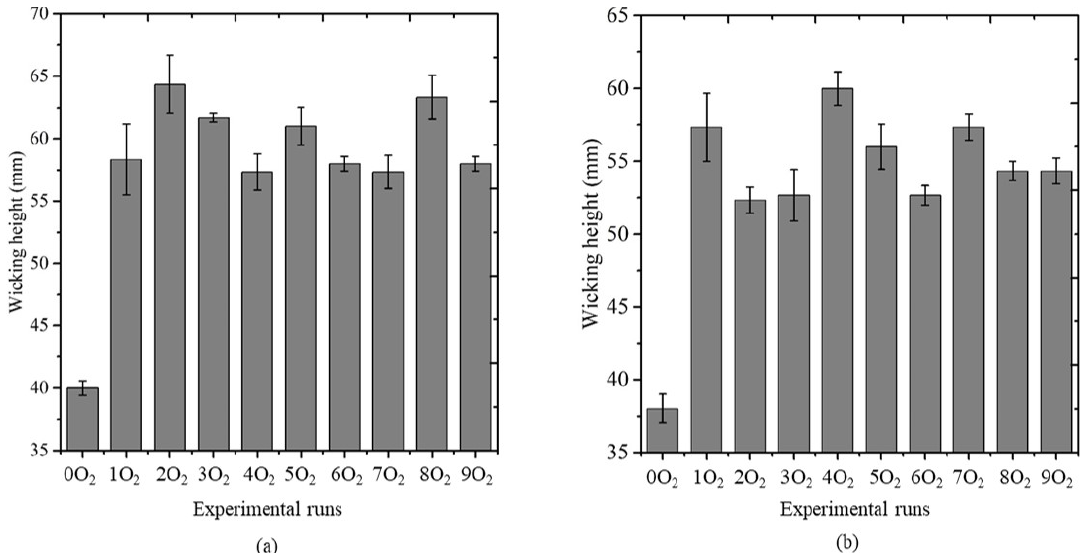
Figure 2. Effect of oxygen plasma on wickability of fabric in warp (a) and weft (b)